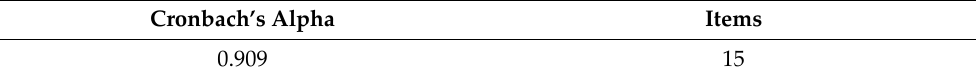
Table 9. Reliability Statistics.